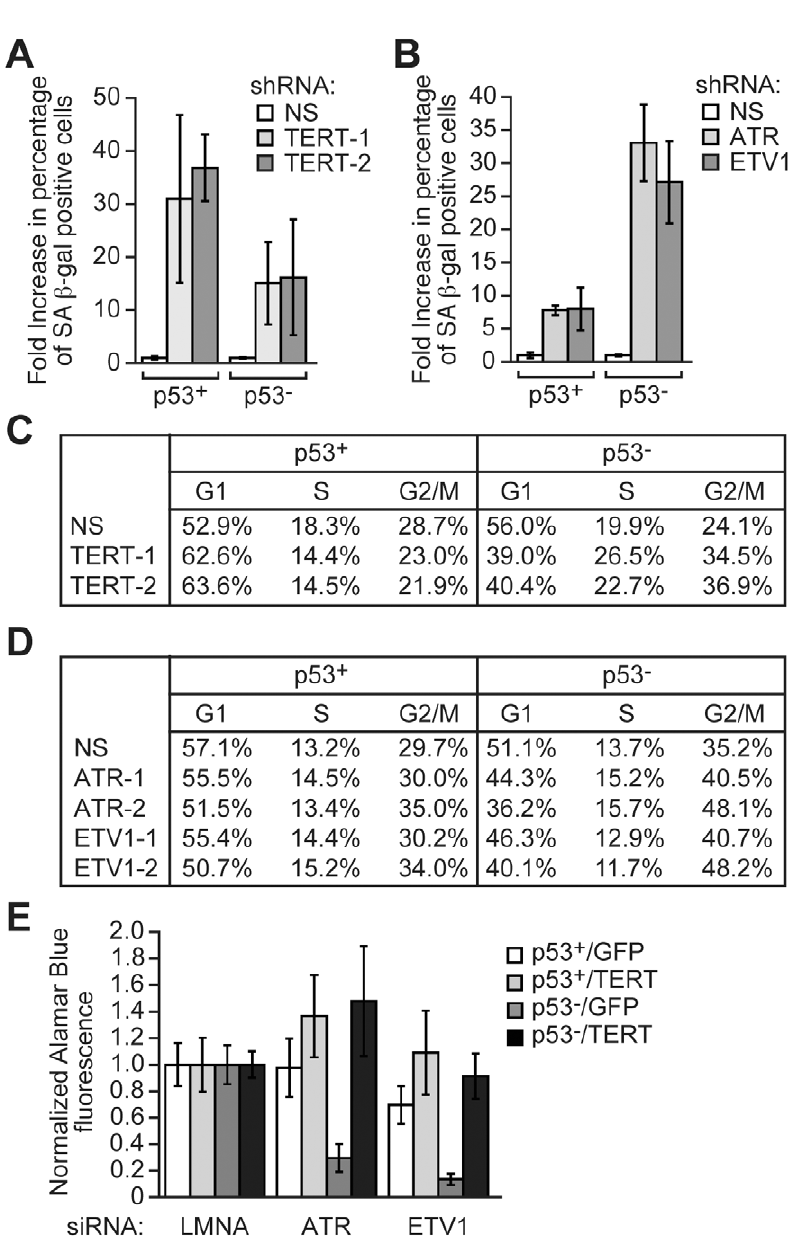
Figure 4. RNAi–mediated knockdown of ATR, ETV1, or TERT induces senescence and prolongs G2/M preferentially in p53 2 cells. (A) Senescence-associated b -galactosidase assay in p53 + and p53 2 HCT116 cells expressing a NS shRNA or one of two unrelated TERT shRNAs. Senescence-associated b -galactosidase activity was normalized to that obtained using a NS shRNA, which was set to 1. Error bars represent SD. (B) Senescence-associated b -galactosidase assay in p53 + and p53 2 HCT116 cells expressing a NS, ATR or ETV1 shRNA. Senescence-associated b - galactosidase activity was normalized to the level obtained using a NS shRNA, which was set to 1. Error bars represent SD. (C) Table showing the percentage of cells in G1, S and G2/M in p53 + and p53 2 HCT116 cells expressing a NS shRNA or one of two unrelated TERT shRNAs. (D) Table showing the percentage of cells in G1, S and G2/M in p53 + and p53 2 HCT116 cells expressing a NS shRNA or one of two unrelated ATR or ETV1 shRNAs. (E) Proliferation of p53 + and p53 2 HCT116 cells transfected with a control (LMNA), ATR or ETV1 siRNA and stably expressing TERT, or as a control GFP, was determined by an Alamar Blue fluorescence assay. Cell proliferation was normalized to that obtained using a LMNA siRNA, which was set to 1. Error bars represent